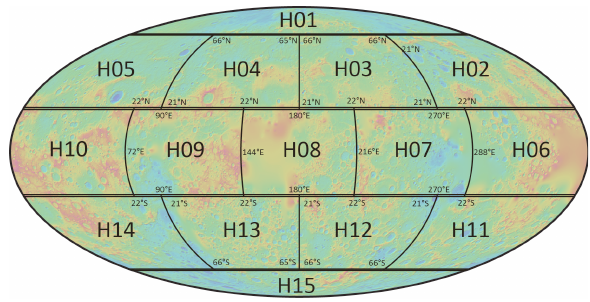
Figure 1: Mercury’s 15 tiles quadrangle